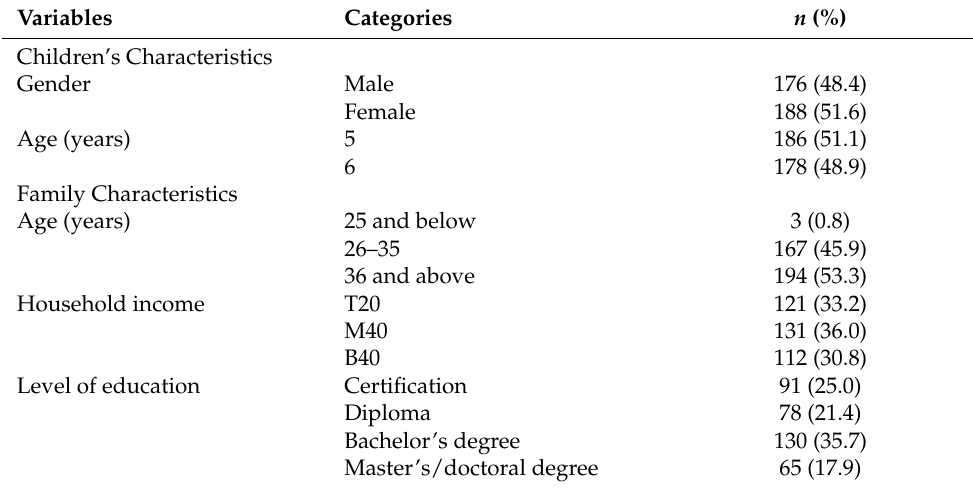
Table 1. Demographic information on the children and their